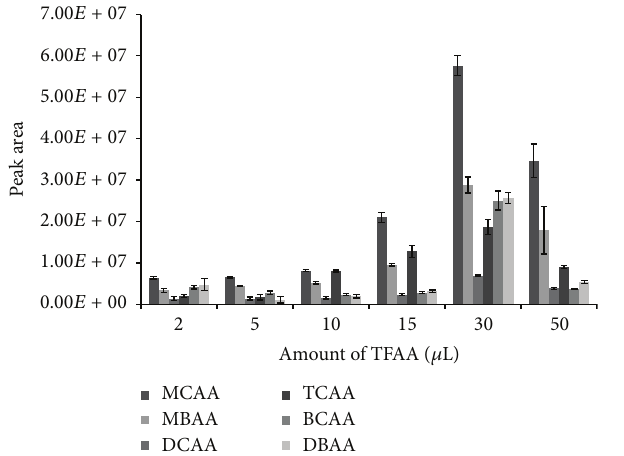
Figure 3: Effect of the amount of catalyst (TFAA) on the simulta- neous liquid-liquid microextraction and derivatization of 0.5 𝜇 gL −1 haloacetic acids at experimental conditions of 10min reaction time, 25 ∘ Ctemperature,and 1mL n -octanolas bothextractant solventand derivatization reagent.